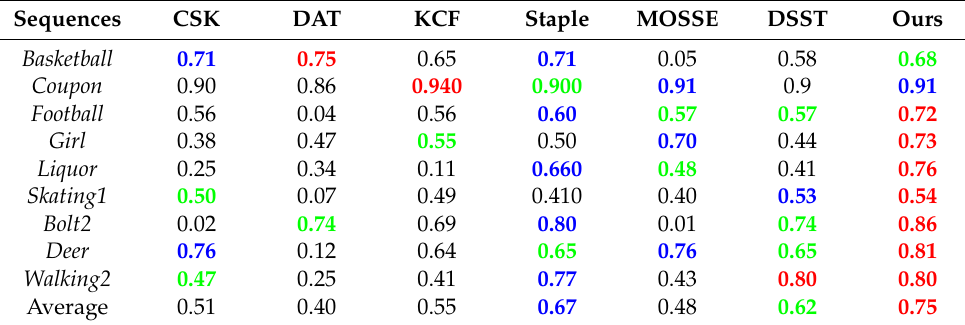
Table 2. Comparison results in terms of average OR. The best three estimates are marked in red, blue, and green fonts in descending order.